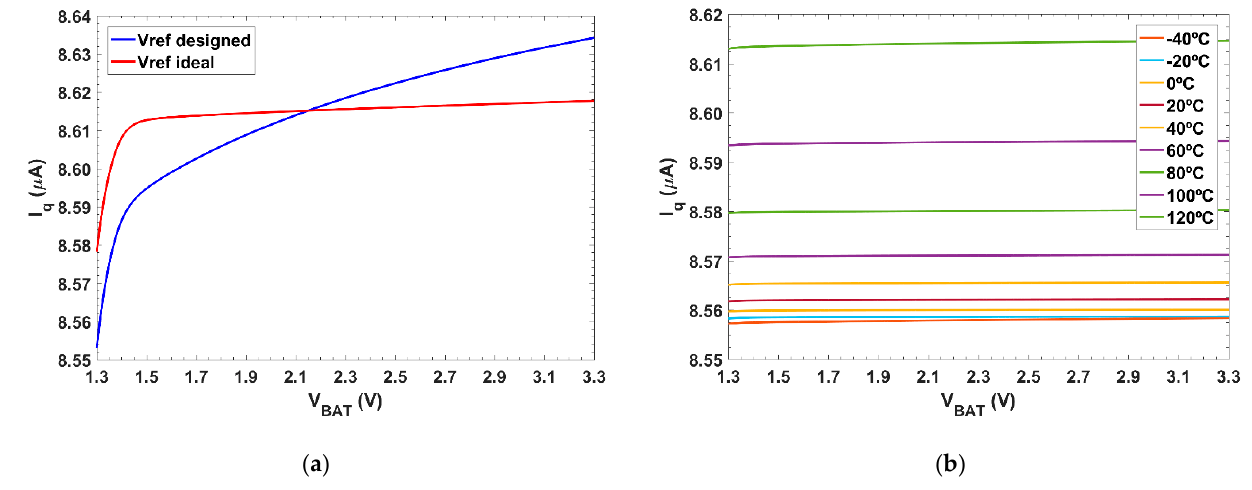
Figure 12. Quiescent current, I q , at: ( a ) room temperature, T room ; and ( b ) different temperatures.